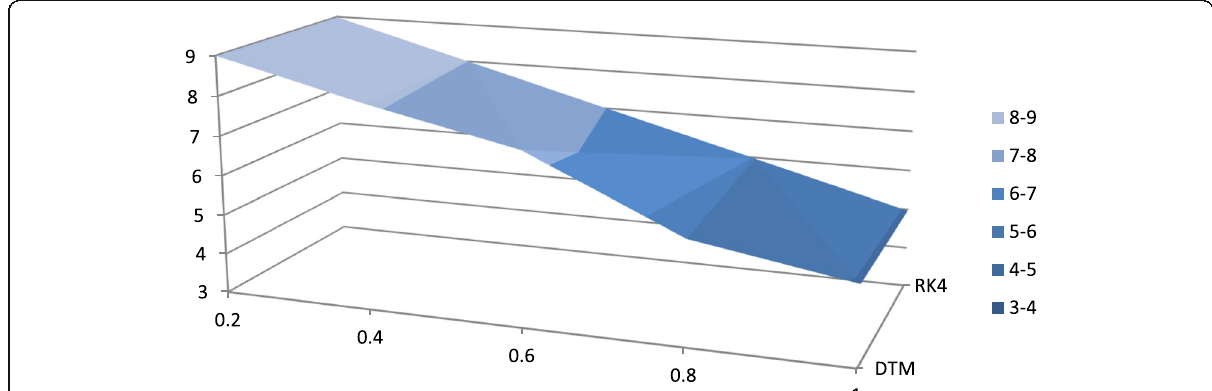
Fig. 13 Description of the sub-population of susceptible individuals who are at the risk of acquiring the